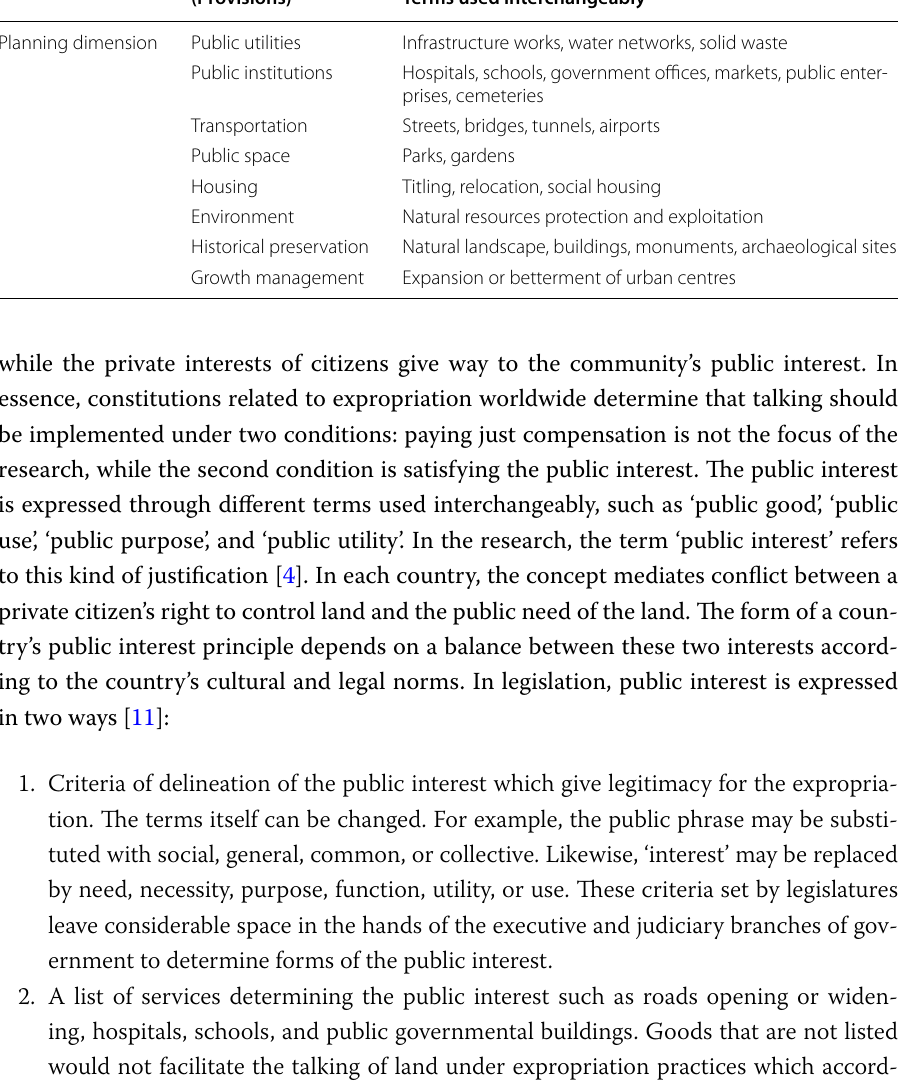
Table 2 Forms of the public interest (Provisions) Planning